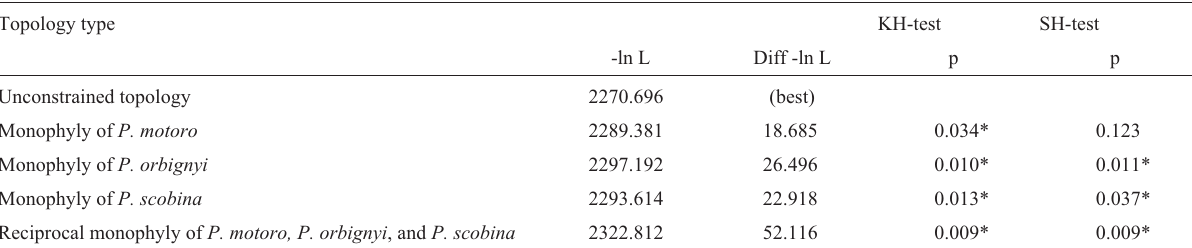
Table 5 - Results of NJ constraint tests of monophyly of species Potamotrygon motoro , P. orbignyi , and P. scobina . *p < 0.05. Topology